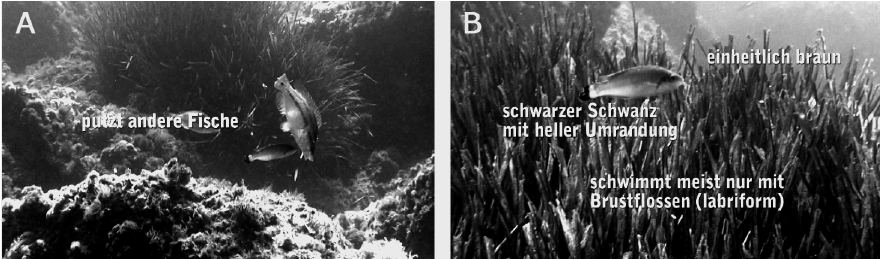
Figure 1. Screenshots of the labelled freeze-frames of the video of Symphodus melanocercus . A. Behavioural aspect. Translation of German text: cleaning other fishes. B. Morphological features, swimming style and colouration. Translation of German text: brown colour (upper right), white edged black tail (middle), swimming exclusively with pectoral fins [labriform swimming